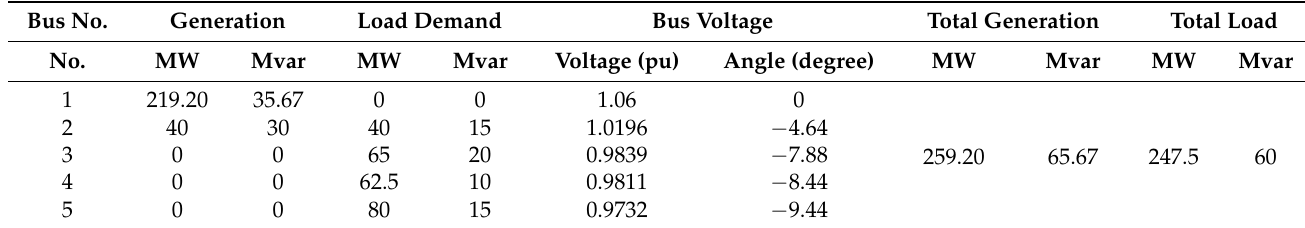
Table 3. Load flow results of the IEEE 5 bus system of case 2.